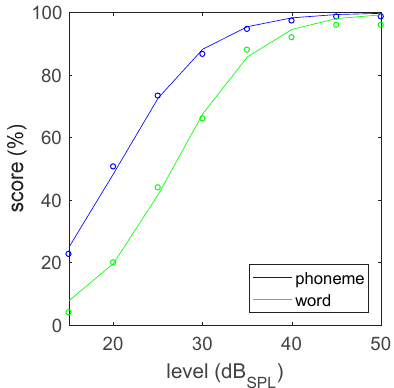
Figure 3. Reference speech recognition curve in quiet. Experimental data (dots) and curve fit (line).